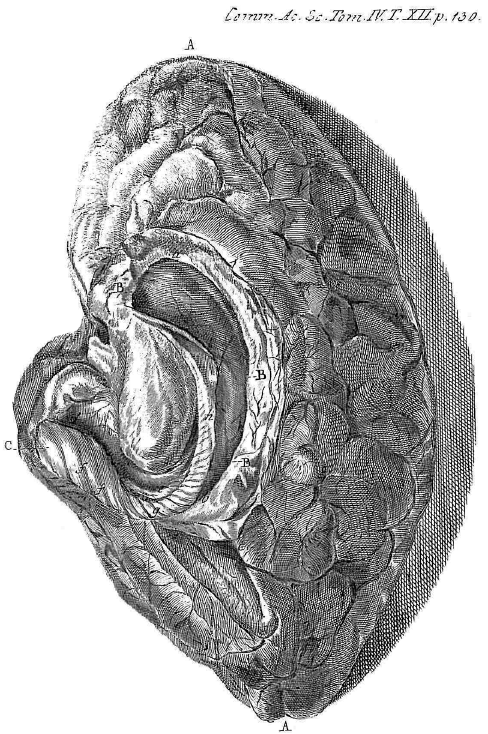
Figure 2. Duvernoy’s Plate XII depicting the drawing of a dissected right hemisphere, displaying the hippocampus and neighboring structures.